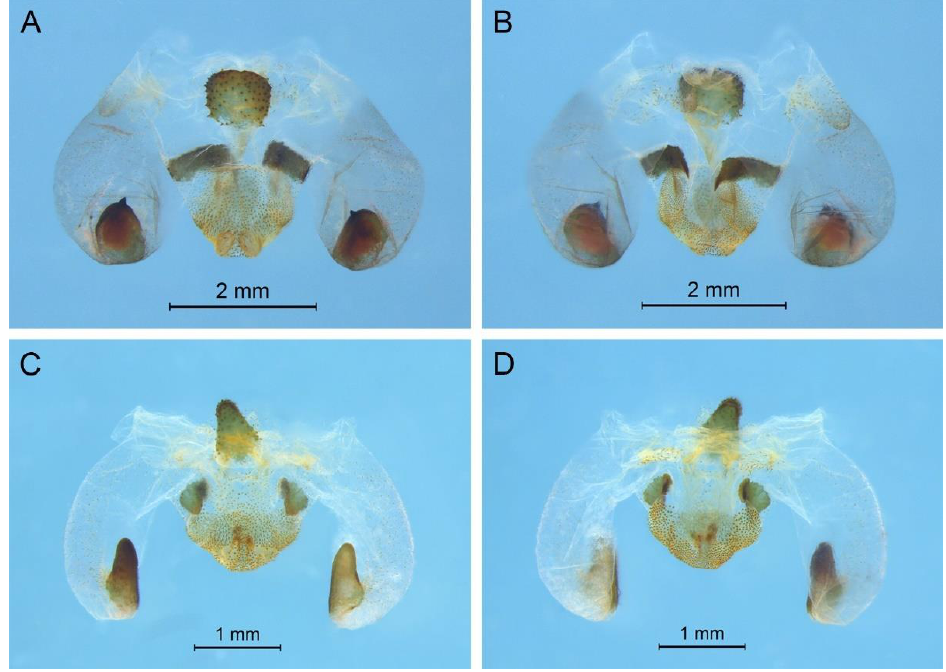
Figure 16. Male genitalia of Homotachycines . ( A , C ) dorsal view, ( B , D ) ventral view: ( A , B ) Homotachy- cines acutilobatus comb. nov.; ( C , D ) Homotachycines ovalilobatus comb. nov.